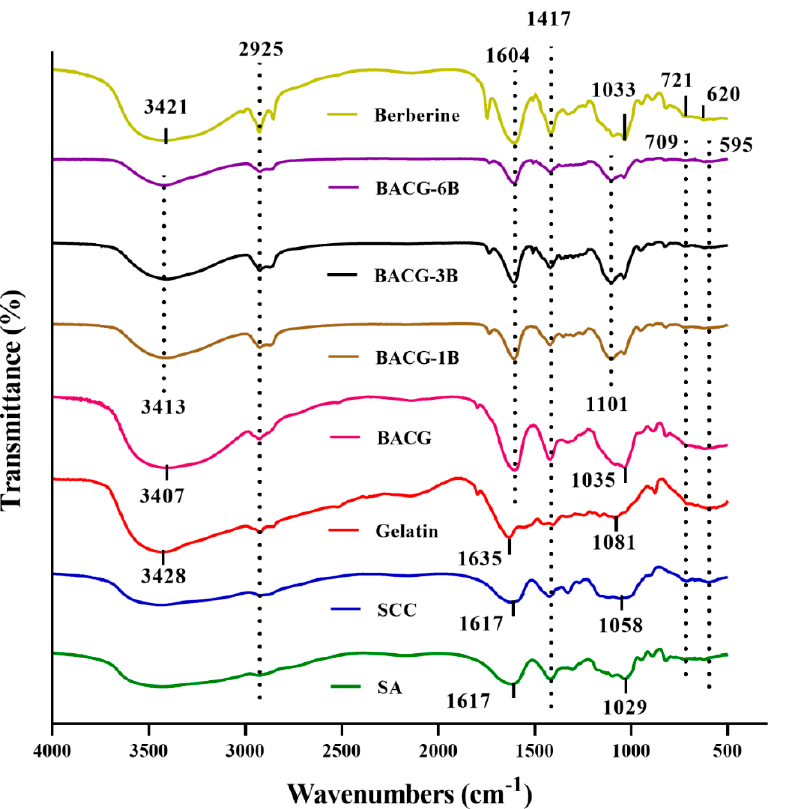
Figure 2. FT-IR spectra of BACG, BACG-1B, BACG-3B, BACG-6B and the raw materials (sodium alginate (SA), sodium carboxymethyl cellulose (SCC), gelatin, and berberine).